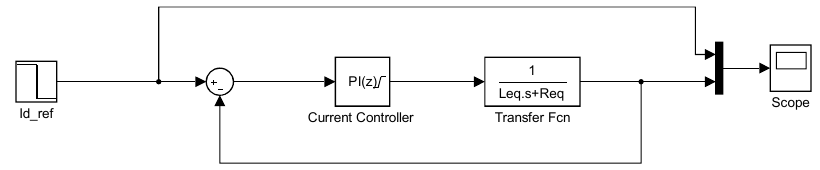
Figure 9. Block diagram for tuning the current-loop PI